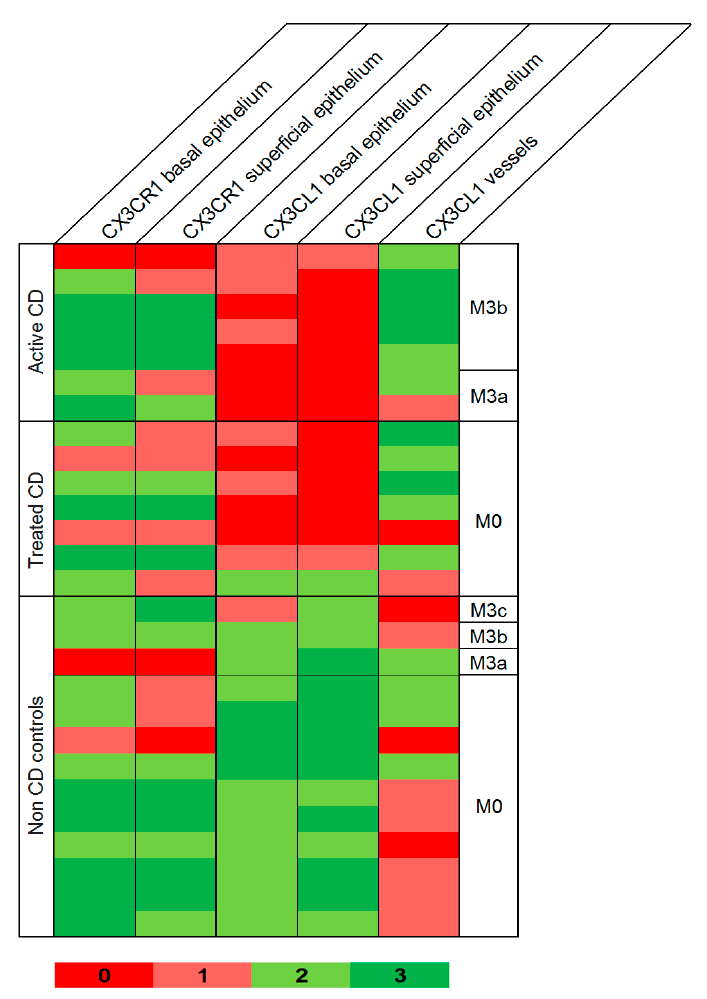
Figure 4. Protein expression of CX3CL1 and CX3CR1 in duodenal tissue detected by immunohistochemistry of all the patients with active and treated coeliac disease and non-coeliac controls analysed. Expression pattern: no stain, 0; weak, 1; moderate, 2; or intense, 3. CD coeliac disease, C controls, Marsh 0/3a/3b/3c, respectively.